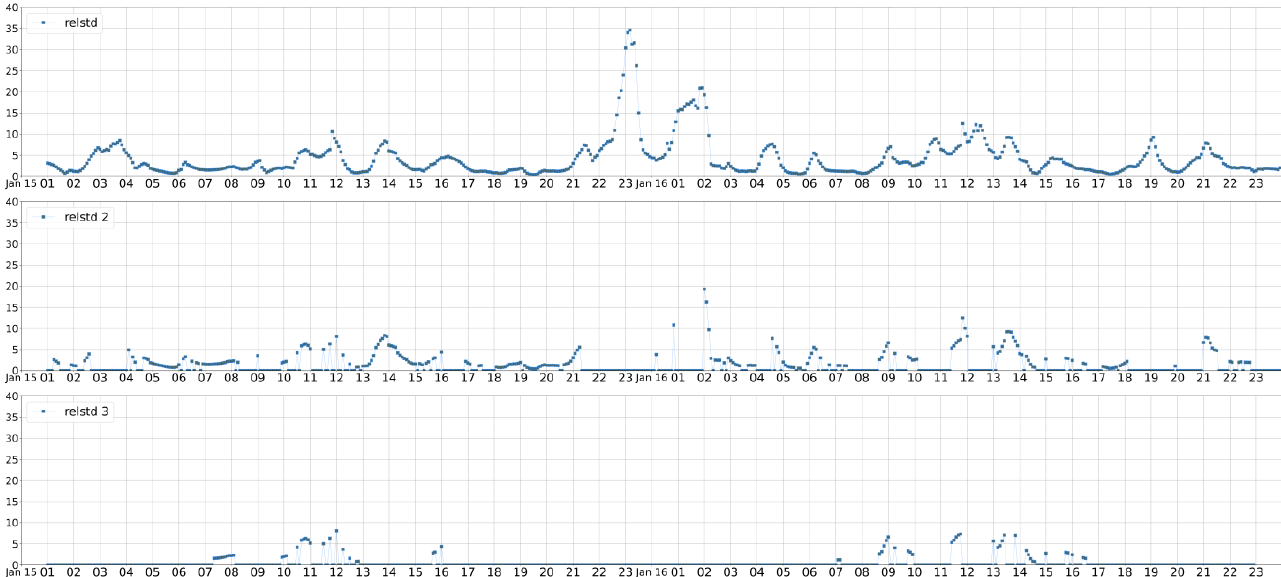
Figure 14. The same as Figure 12, for Ebre.